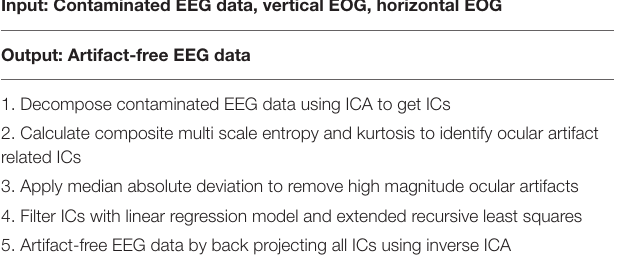
TABLE 1 | Summary of the proposed